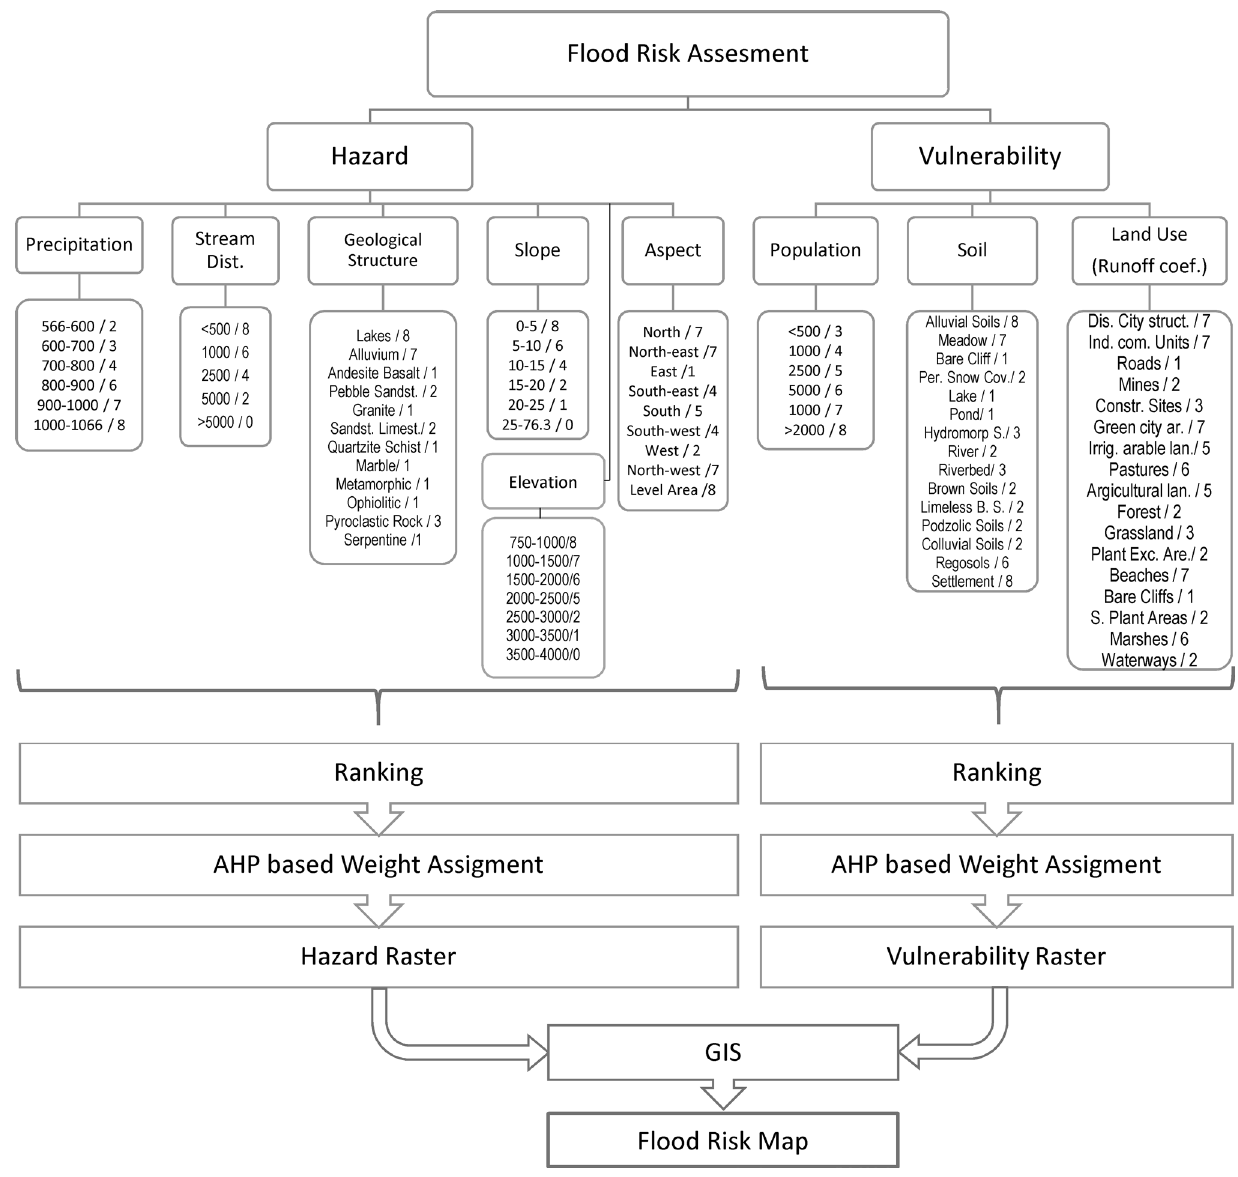
Fig. 3 Hierarchical framework of the flood risk